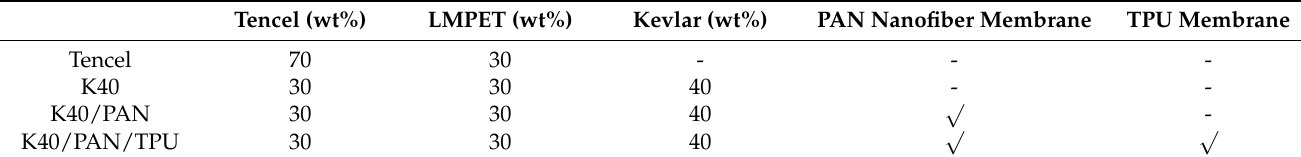
Table 1. Specifications and denotations of nonwoven fabrics and lay-up compound